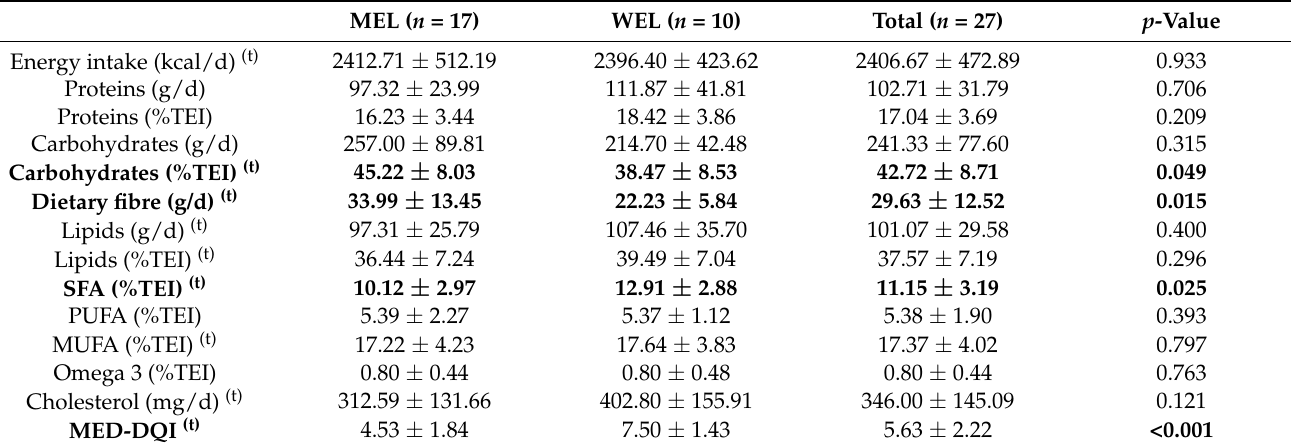
Table A2. Energy intake, calorie profile of nutrients and